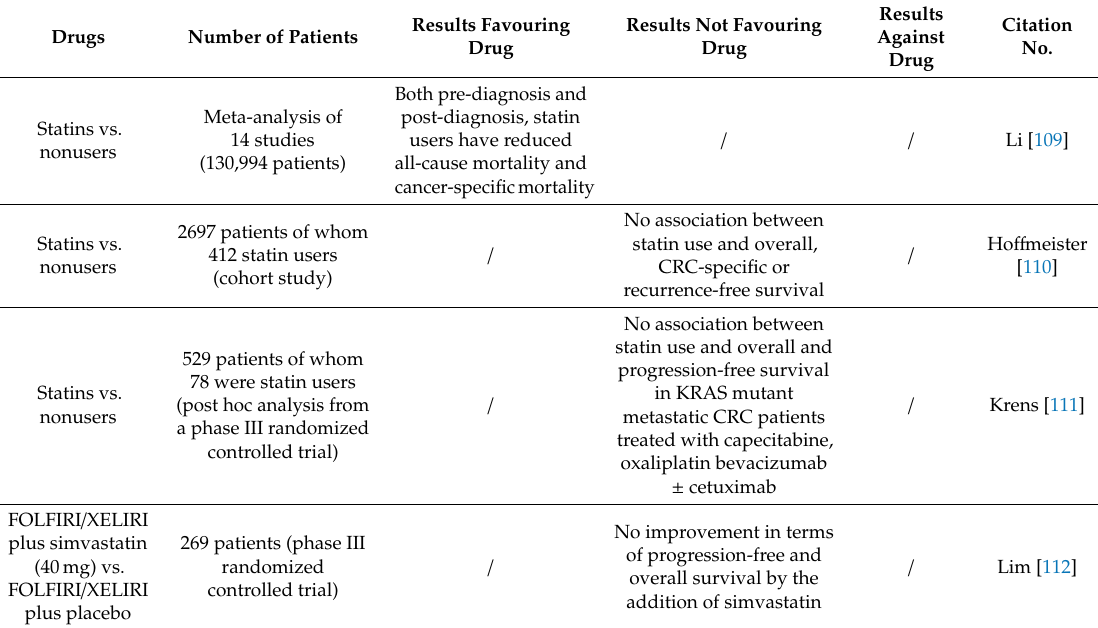
Table 4. Summary of studies for statins as a prognostic